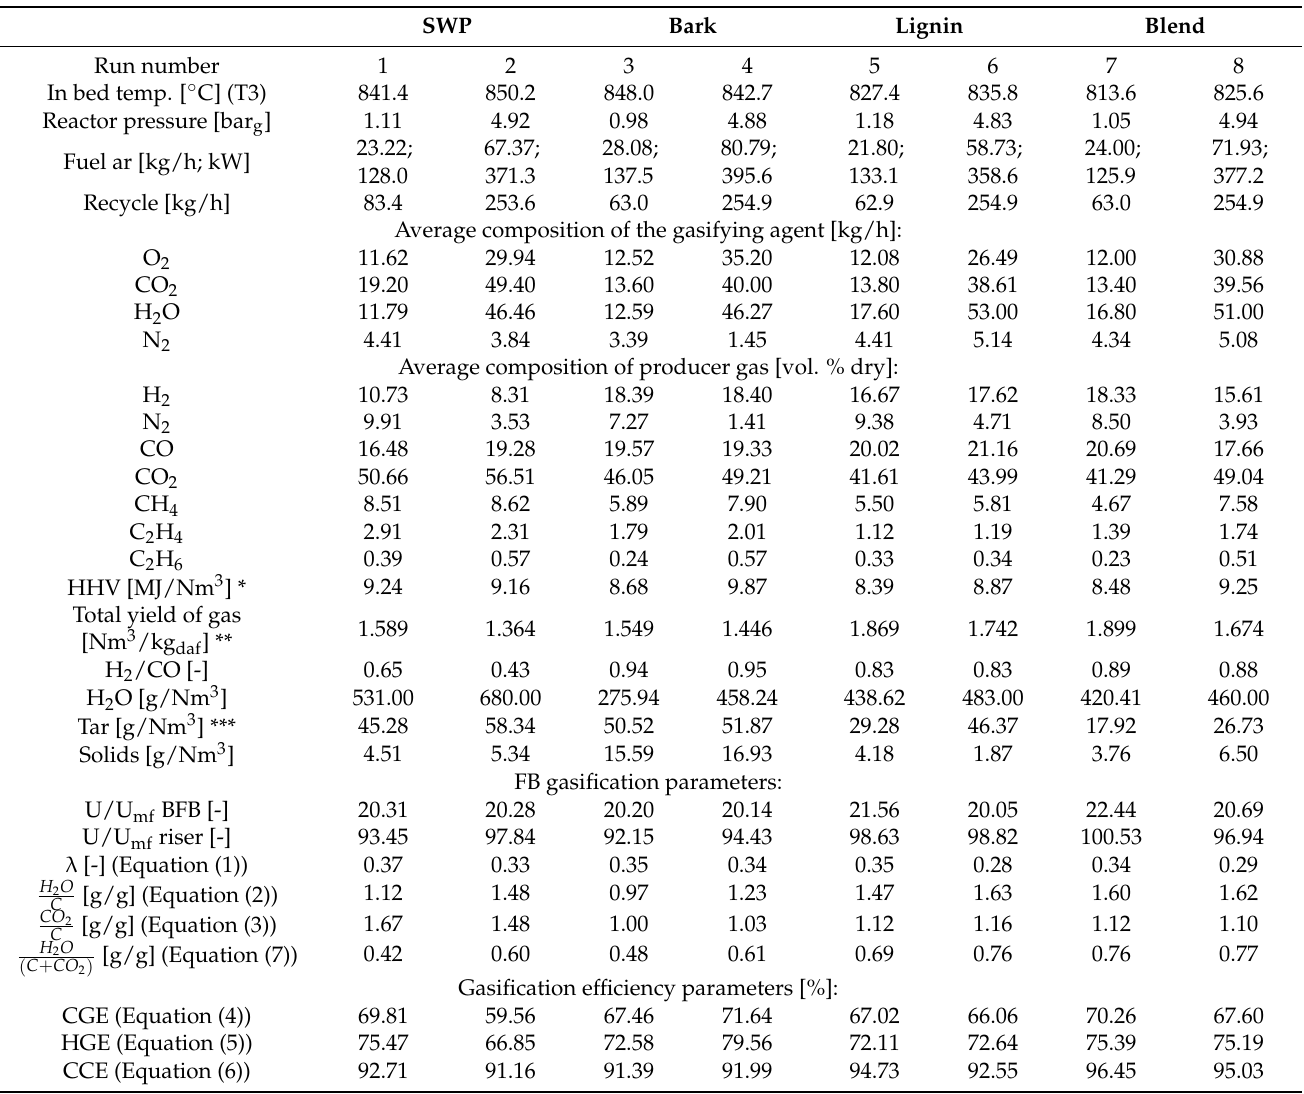
Table 3. Results of experimental test runs, process efficiency parameters and indices. SWP Bark Lignin